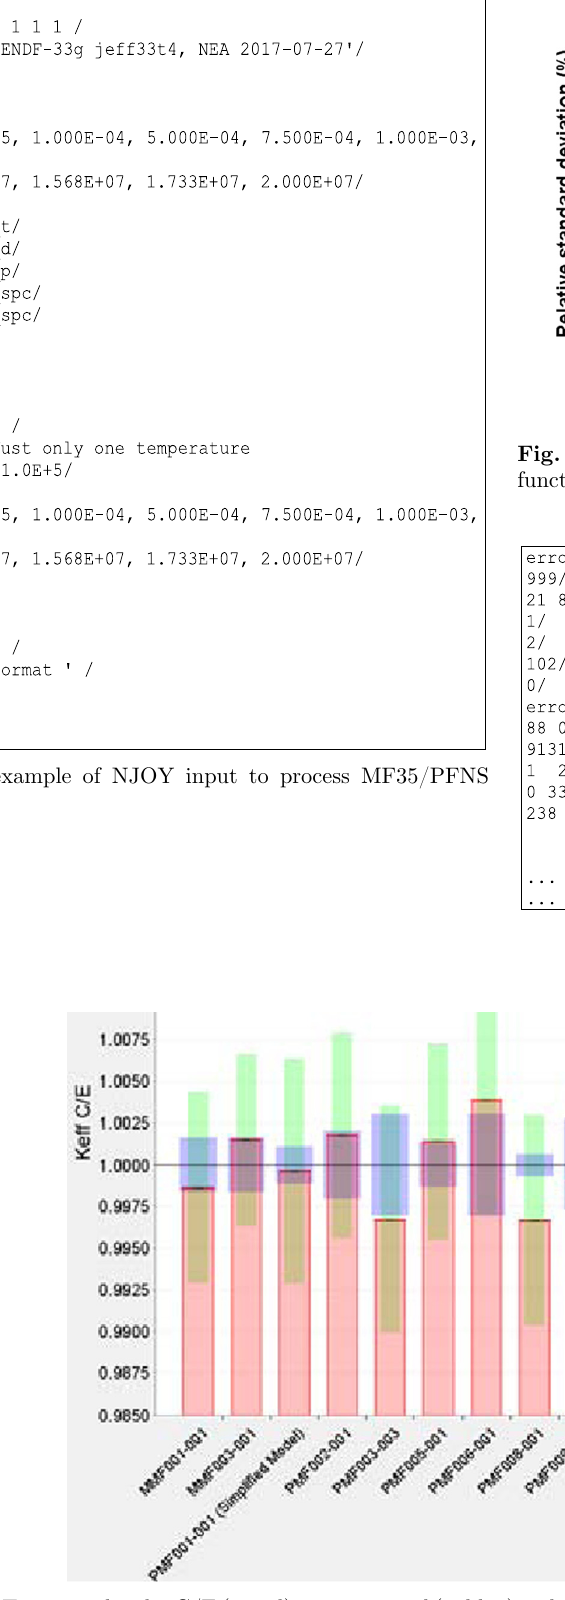
Fig. 7. NDaST output plot, k eff C/E (in red), experimental (in blue) and propagated nuclear data uncertainties (in green) due to 239 Pu covariance of JEFF-3.3T4.